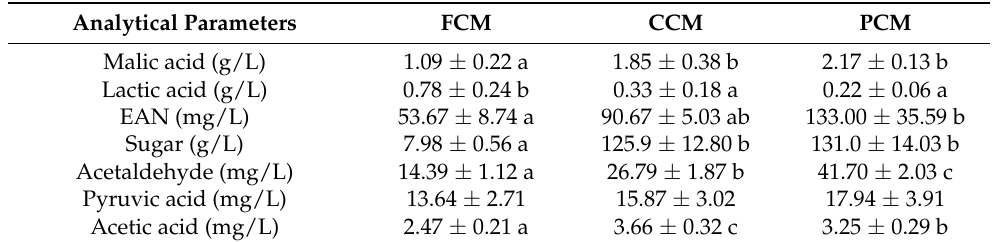
Table 1. Analysis of the three different fractions obtained at devatting moment of carbonic maceration wines (FCM: free wine, CCM: crushed wine, PCM: press wine). Different letters in the same line mean significant differences between samples ( p < 0.05).